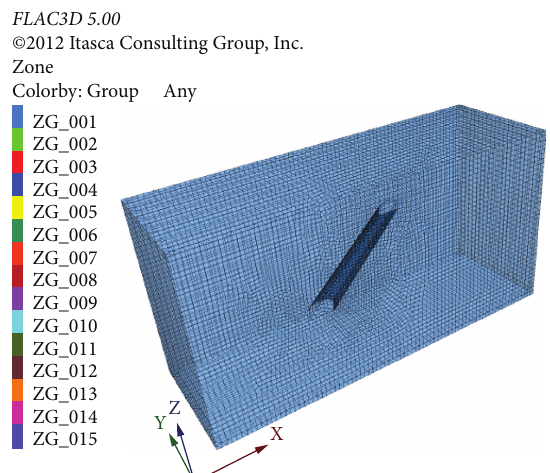
Figure 16: Model and grid partition